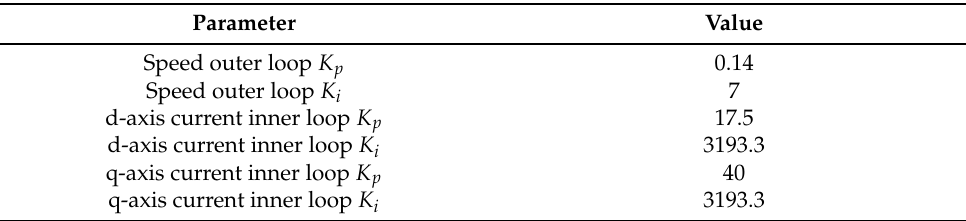
Table 5. Parameters of the three PI controllers.